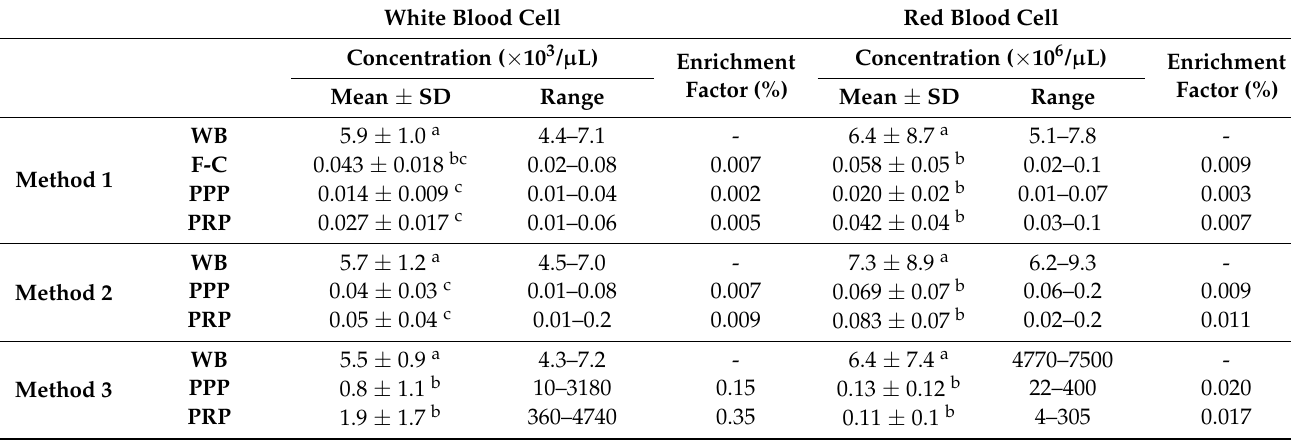
Table 3. WBC and RBC counts in WB, PRP, and PPP of 18 mares, having WB harvested and processed by three methods to prepare PRP for intrauterine infusions in mares. Method 1 consisted of collecting WB in a blood transfusion bag, centrifugation of WB at 400 × g /10 min (F-C), and centrifugation of plasma at 1000 × g /10 min. Method 2 consisted of one centrifugation at 120 × g /10 min. Method 3 consisted of collecting WB in a syringe and then letting it sediment in an upright position for 4 h. After processing, PRP and PPP were obtained across methods, and WBC and RBC counted. White Blood Cell Red Blood